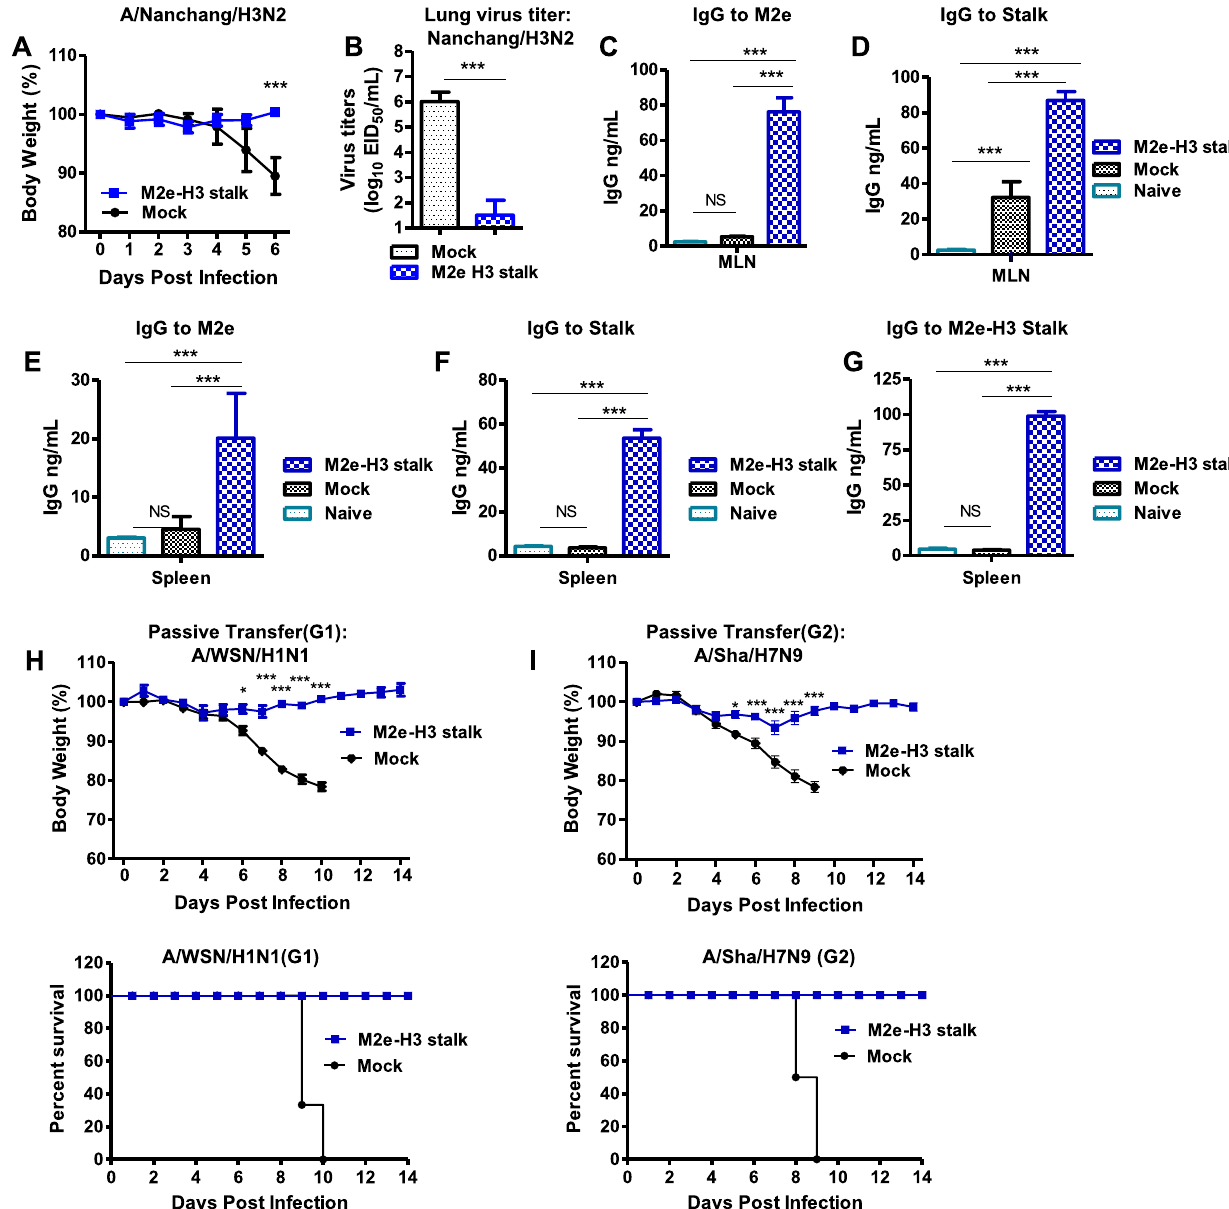
Fig. 6 Adjuvanted M2e-H3 stalk vaccination bestows cross protection by lowering lung viral loads and inducing protective humoral immune responses. A Body weight changes in M2e-H3 stalk (20 µg) vaccinated young BALB/c mice ( n = 5) for 6 days after challenge with lethal dose (2xLD 50 , 3 × 10 6 EID 50 ) of A/Nanchang/H3N2 virus. B Lung viral titers at 6 days post-infection. C – G In vitro production of IgG antibodies speci fi c for M2e ( C ) and stalk ( D ) in mediastinal lymph node (MLN) and spleen cultures IgG antibodies speci fi c for M2e ( E ), stalk ( F ) or M2e-H3 stalk ( G ), determined by ELISA. H , I Protective ef fi cacy of vaccine immune sera. Body weight changes in naïve mice after intranasal inoculation with a mixture of M2e-H3 stalk vaccine immune sera or naive sera and group 1 in fl uenza A virus (A/WSN H1N1, 4.2xLD 50 ) ( H ) and group 2 in fl uenza A virus (A/rgH7N9, 5xLD 50 ) ( I ). Mock: mock group (adjuvant only no vaccine group ( A – G ) with virus infection). Naïve: mice group with no immunization and no virus infection. Mock: adjuvanted naïve sera ( H , I ). Statistical signi fi cance was determined by using